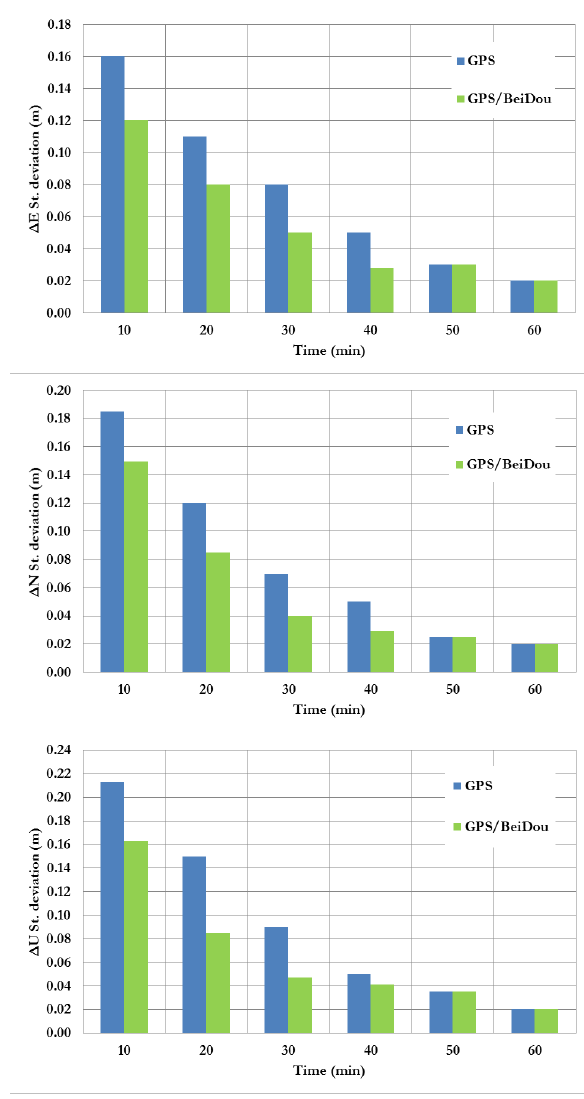
Figure 6: Summary of positioning standard deviations in East, North, and Up directions of two PPP models